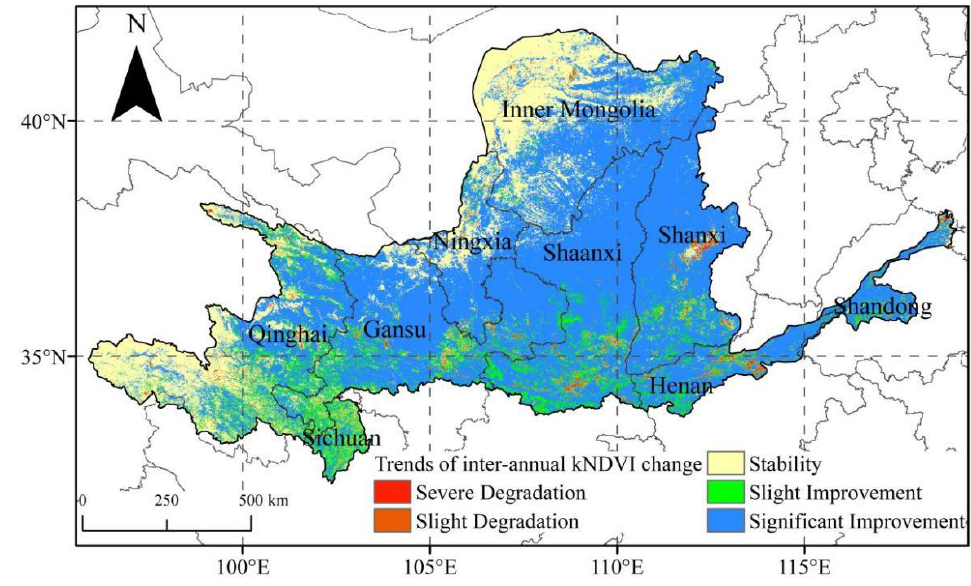
Figure 5. Trends of inter-annual kNDVI change in the YRB from 2001 to 2020.